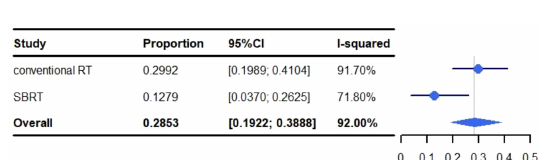
FIGURE 3 Meta-analysis and forest plots for non-small cell lung cancer patients treated with radiotherapy/chemoradiotherapy and immune checkpoint inhibitors who experienced grade 5 adverse events.